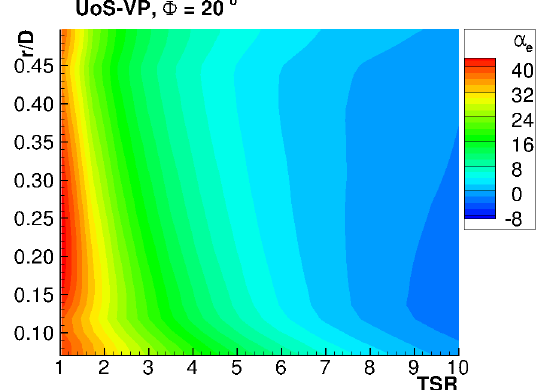
Figure 20. UoS-VP turbine. Effective angle of attack α e as a function of radius r and of turbine operating condition ( TSR ). Design pitch setting Φ = 20 ◦ .